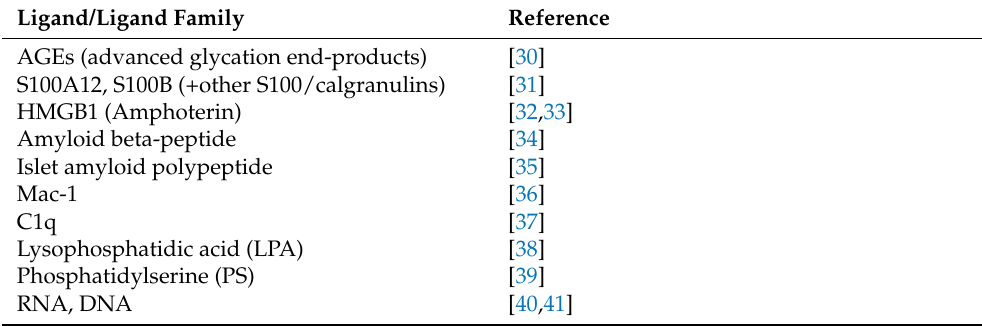
Table 1. Examples of major ligands that bind to the extracellular domains of RAGE. Ligand/Ligand